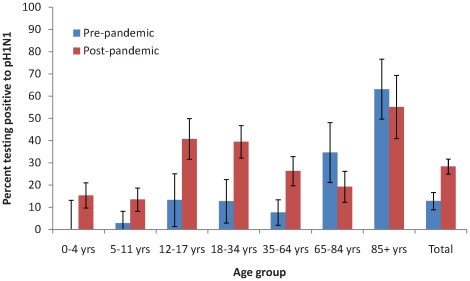
Prevalence of antibody to pandemic influenza A (H1N1) 2009.Data are percentages of subjects with H1N1 haemagglutinating antibody titres≥40, in pre- and post-pandemic samples, from New South Wales residents by age group.